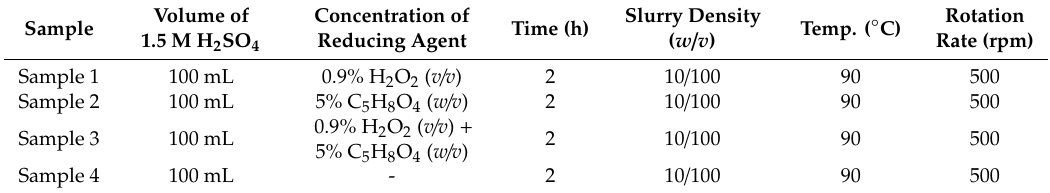
Table 1. Summary of the best operational conditions for leaching the battery